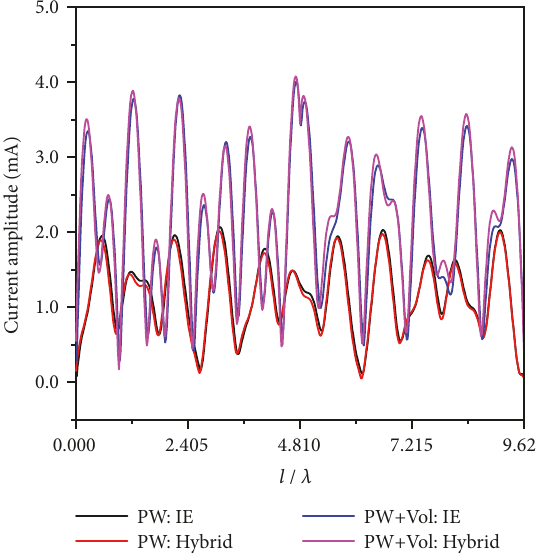
Figure 4: Currents on the straight